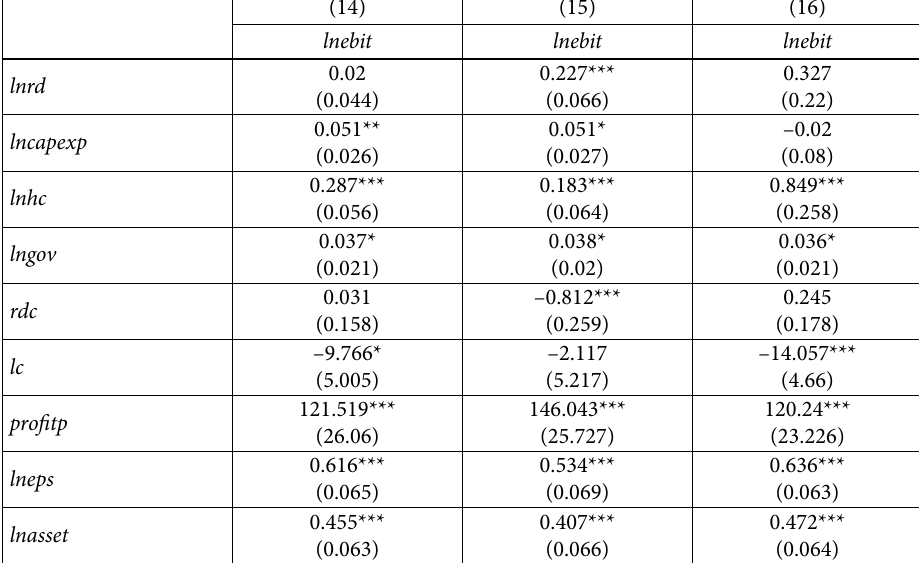
Table A4. Robustness test for endogeneity problem (Weak endogenous